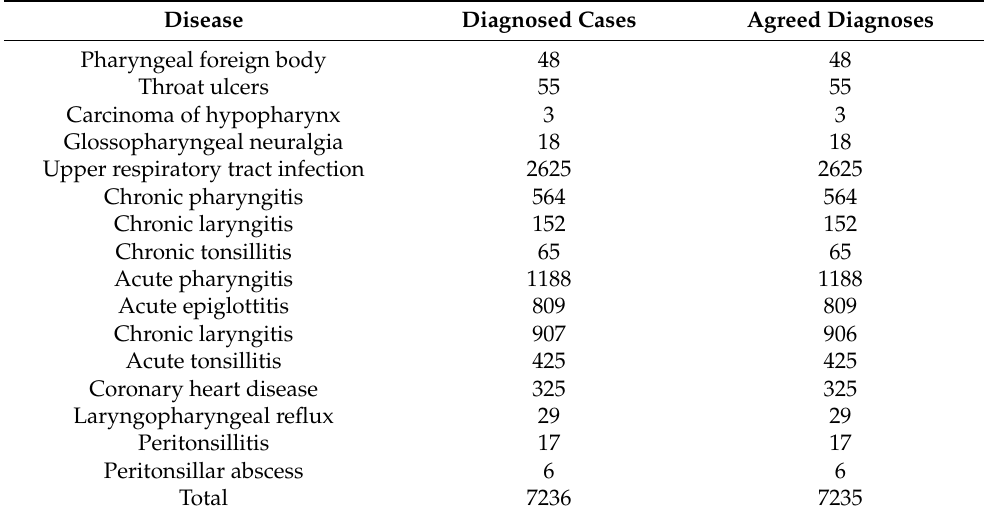
Table 5. Application of sore throat diagnostic model in primary hospitals in Jiaozhou